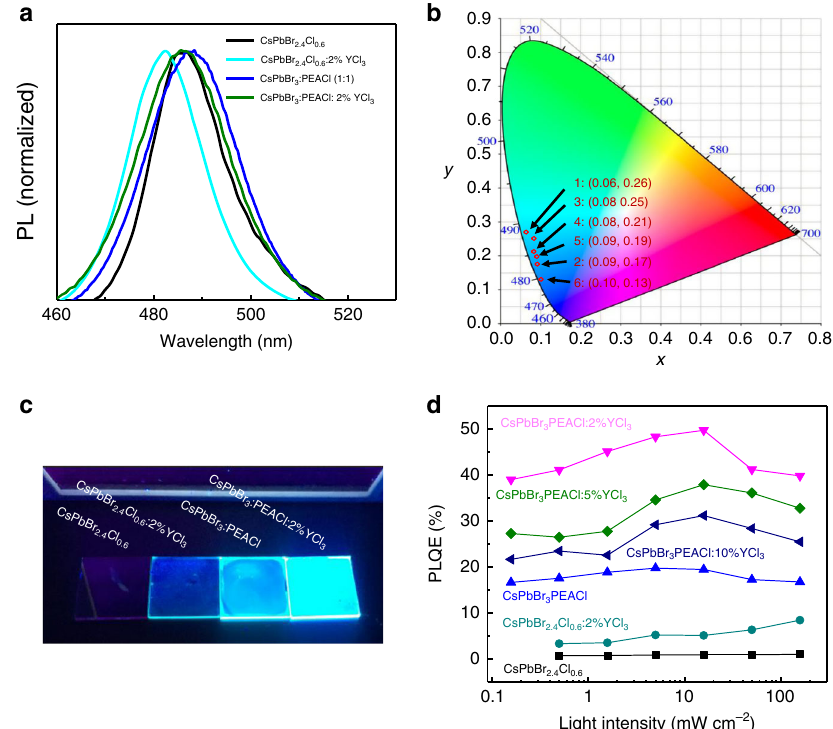
Fig. 1 Photoluminescence enhancement by PEACl and YCl 3 incorporation in perovskite fi lms. a PL spectra of CsPbBr 2.4 Cl 0.6 , CsPbBr 2.4 Cl 0.6 :2%YCl 3 , CsPbBr 3 :PEACl (1:1), and CsPbBr 3 :PEACl:2%YCl 3 fi lms. b CIE coordinates of CsPbBr 2.4 Cl 0.6 (1), CsPbBr 2.4 Cl 0.6 :2%YCl 3 (2), CsPbBr 3 :PEACl (1:1) (3), and CsPbBr 3 :PEACl:2%YCl 3 (4) fi lms. CIE coordinates of CsPbBr 3 :PEACl:2%YCl 3 (5) device and CsPbBr 3 :PEACl:10%YCl 3 (6) device. c A photograph of the fi lms under UV lamp. The composition of each fi lm is labeled in the photograph. d Power-dependent PLQEs of the perovskite fi lms with different